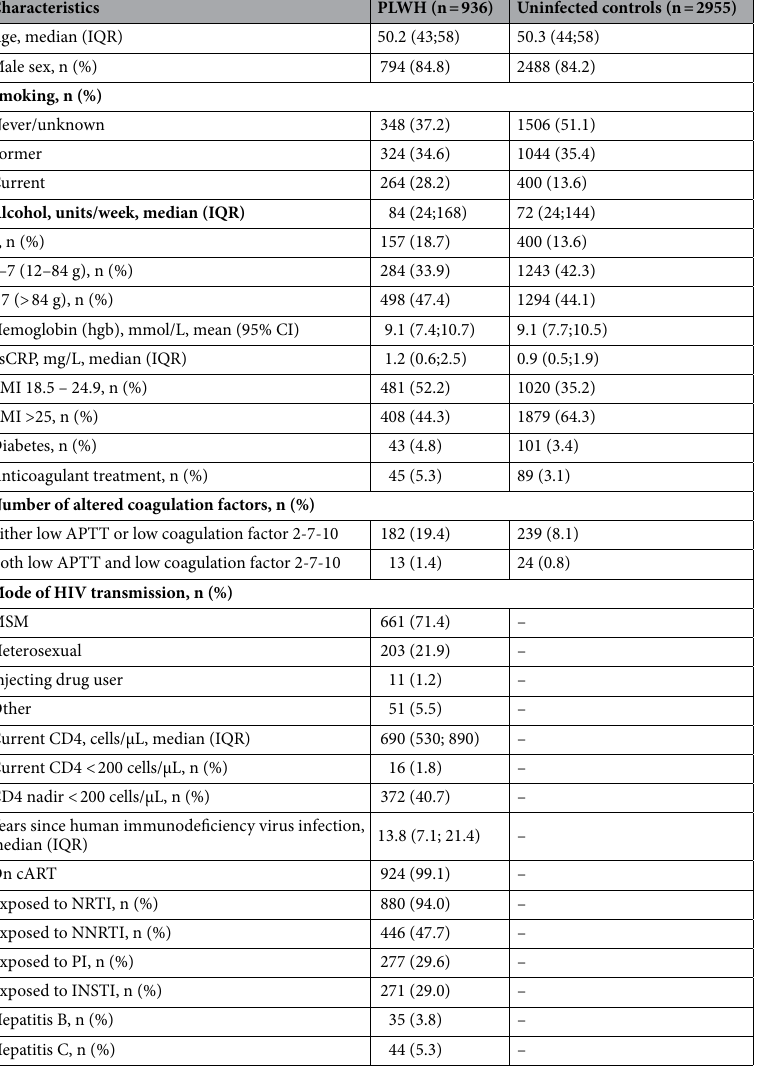
Table 1. Characteristics of PLWH and uninfected controls. BMI Body Mass Index, cART combination antiretroviral therapy, hsCRP high sensitivity C-reactive protein, MSM men who have sex with men, NRTI nucleoside/nucleotide reverse transcriptase inhibitors, NNRTI non-nucleoside reverse transcriptase inhibitors, PI protease inhibitors, INSTI integrase inhibitors. Definition of hepatitis B and hepatitis c co-infection was a positive HBsAg and a positive HCV-RNA,